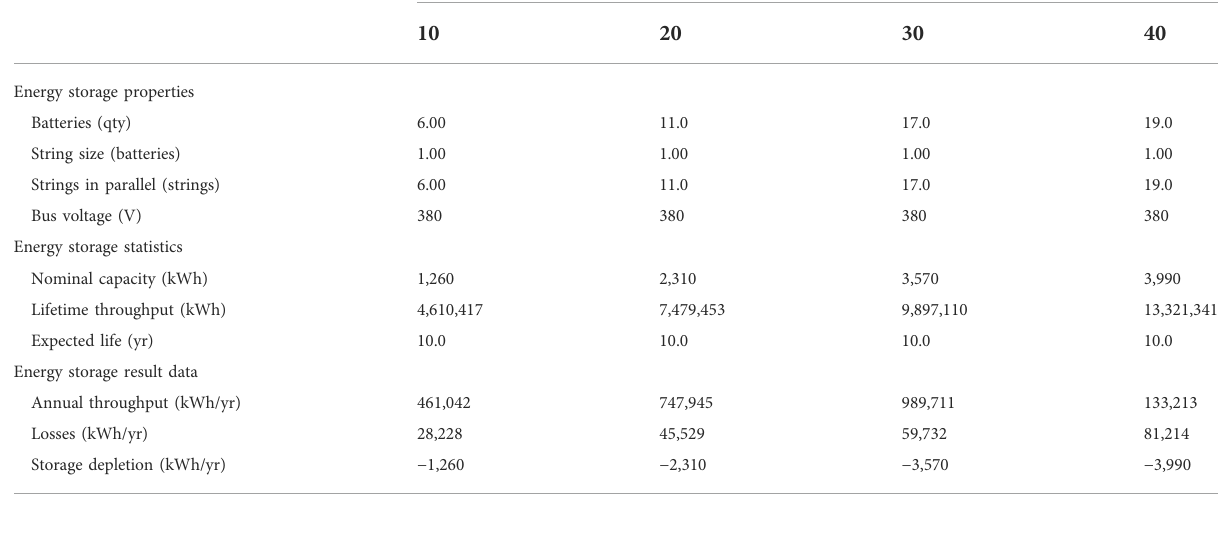
TABLE 2 Energy storage system sizing and energy results.